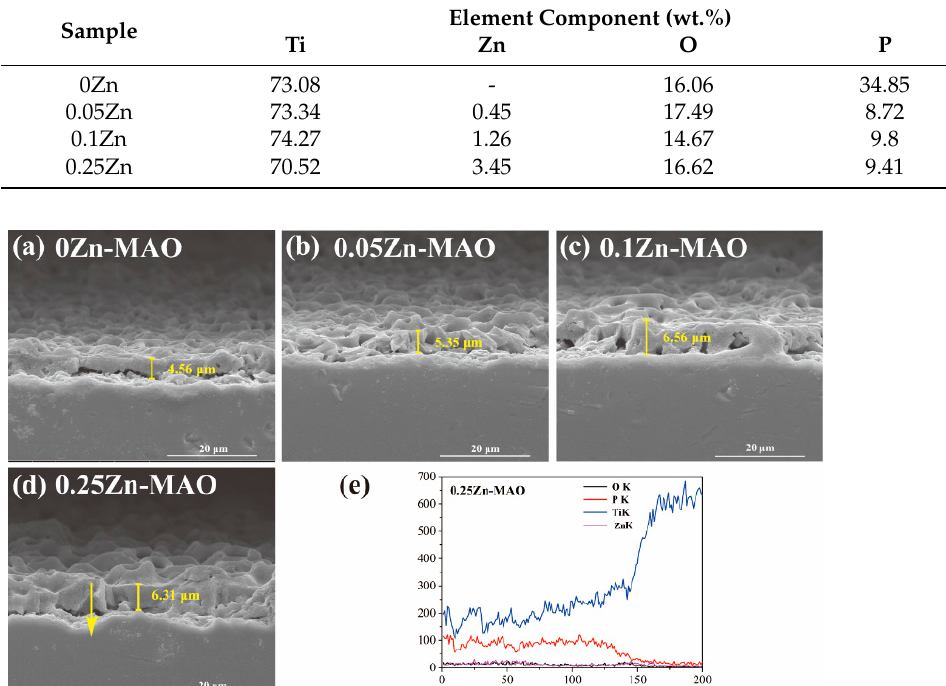
Table 2. Element component (wt.%) on the surface of different coatings.